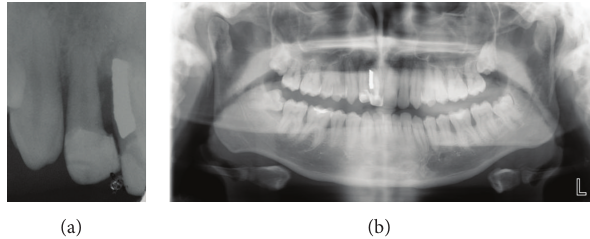
Figure 6: Periapical and panoramic radiographs showed a severe vertical bone